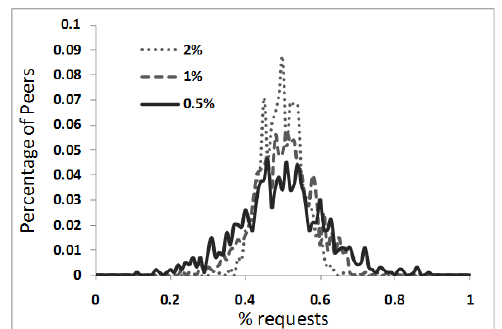
Fig. 1. Diversity of the percentage of requests that is received by individual